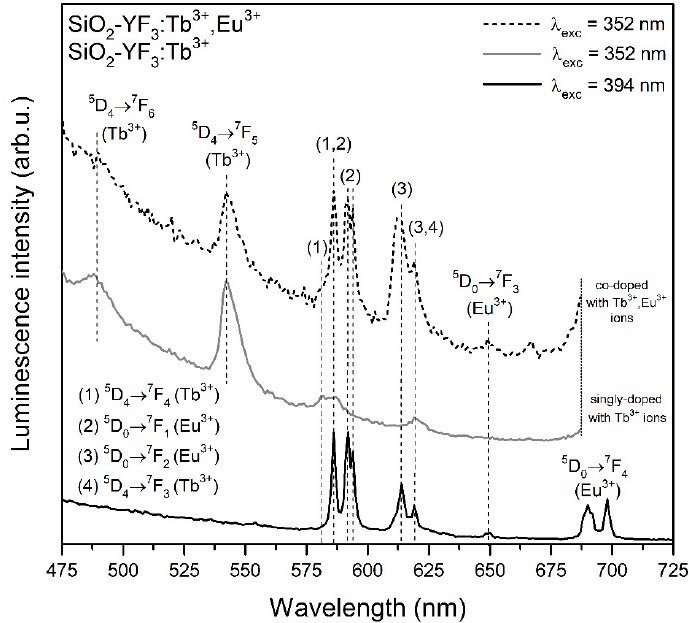
Figure 7. PL spectra of SiO 2 -YF 3 :Tb 3 + and SiO 2 -YF 3 :Tb 3 + ,Eu 3 + samples recorded under NUV excitation at λ exc = 352 nm and λ exc = 394 nm.